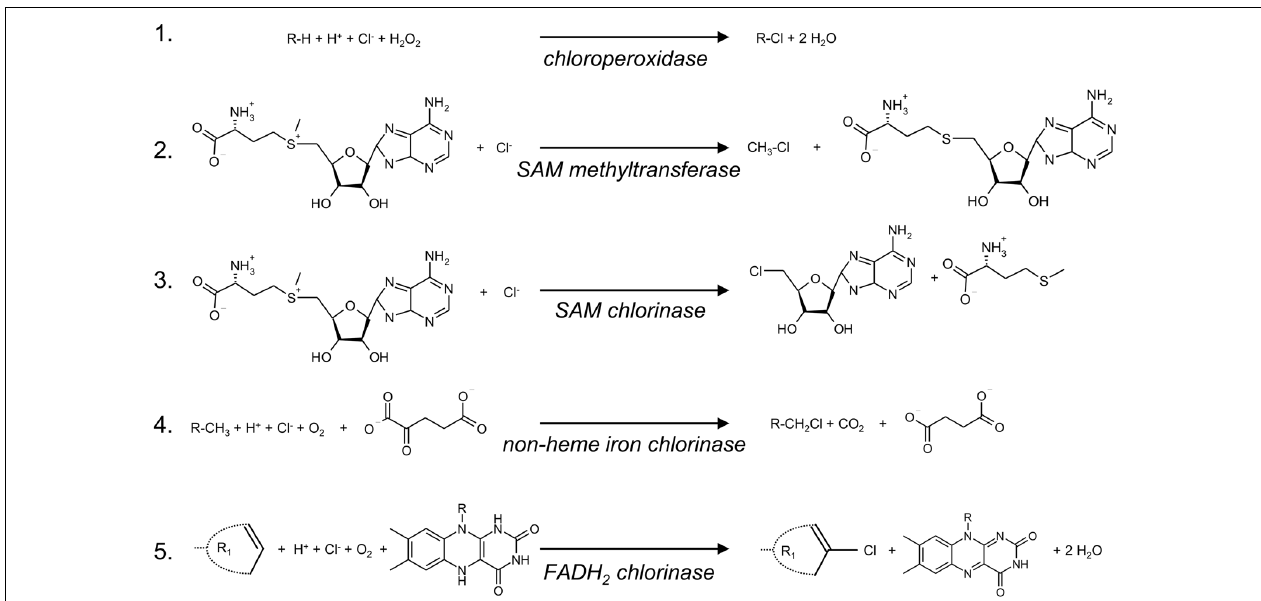
FIGURE 2 | Schematic overview of enzymatic chlorination reactions. Reaction 1 is an electrophilic chlorination reaction of an alkyl group (R) catalyzed by heme- or vanadium-containing chloroperoxidases. Reactions 2 and 3 are nucleophilic chlorination reactions catalyzed by SAM-dependent methyl transferases that lead to the formation of mono substituted alkanes (2) or to the formation of 5 (cid:48) -chloro deoxyadenosine (3), which is the precursor of salinosporamide A. Reaction 4 is a radical chlorination at unactivated carbon centers and is catalyzed by an α -ketoglutarate-dependent non-heme iron chlorinase. Reaction 5 mainly leads to chlorination of tryptophan, phenol or pyrrole ring structures catalyzed by FADH 2 -dependent chlorinases. R1 represents a phenol, pyrrole or tryptophan